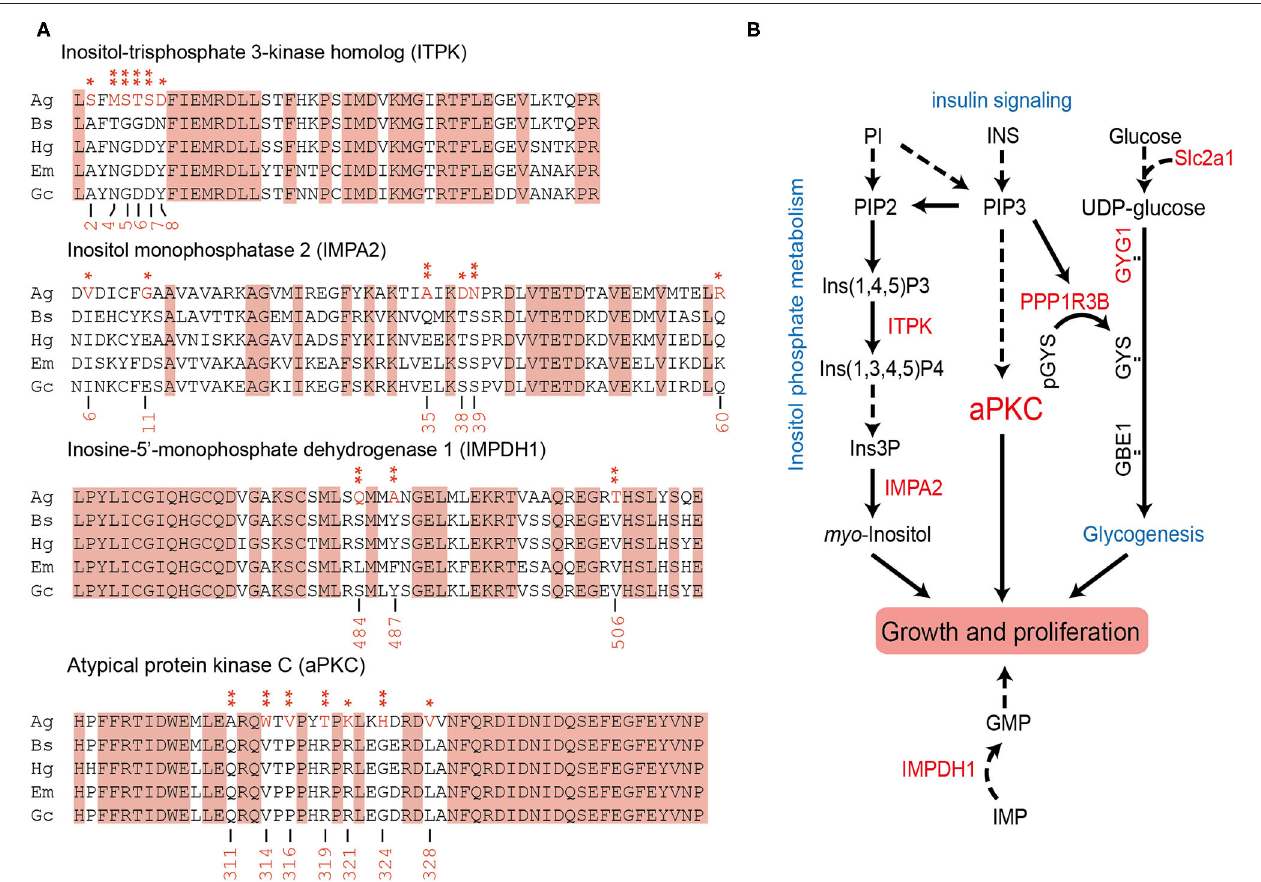
FIGURE 5 | The possible signaling pathways involved by the PSGs solely identified in the “supergiant” A. gigantea. (A) The positively selected sites in the four PSGs (ITPK, IMPA2, IMPDH1, and aPKC) were solely identified in A. gigantea. To detect PSGs solely identified in the “supergiant” A. gigantea, we calculated by setting A. gigantea as the foreground and the other two small hadal amphipods ( B. schellenbergi and H. gigas ) as well as the two shallow-water amphipods ( Gammarus chevreuxi and Echinogammarus marinus ) as the background. The positively selected sites were marked in red asterisks. (B) The seven PSGs (ITPK, IMPA2, IMPDH1, aPKC, PPP1R3B, GYG1, and Slc2a1) were solely identified in A. gigantea were involved in inositol phosphate metabolism, insulin signaling, and glycogenesis signaling, which were related to growth and proliferation. PI, phosphatidylinositol; PIP2, phosphatidylinositol-4,5-bisphosphate; Ins(1,4,5)P3,